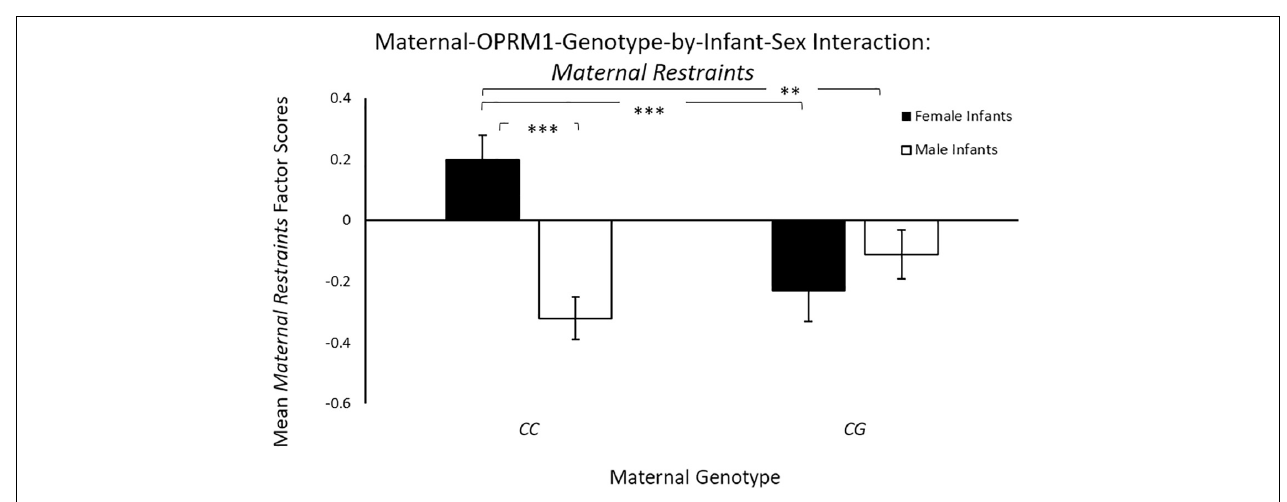
FIGURE 1 | Results showed a significant two-way sex-by-maternal-genotype interaction for Attachment ( p < 0.001), with CC mothers with daughters exhibiting higher Attachment scores on average, when compared to CG mothers with daughters (p = 0.014) or to CC mothers with sons ( p = 0.69). White bars represent mothers with male offspring, and black bars represent mothers with female offspring; * p < 0.05, ** p < 0.01, and *** p < 0.001.